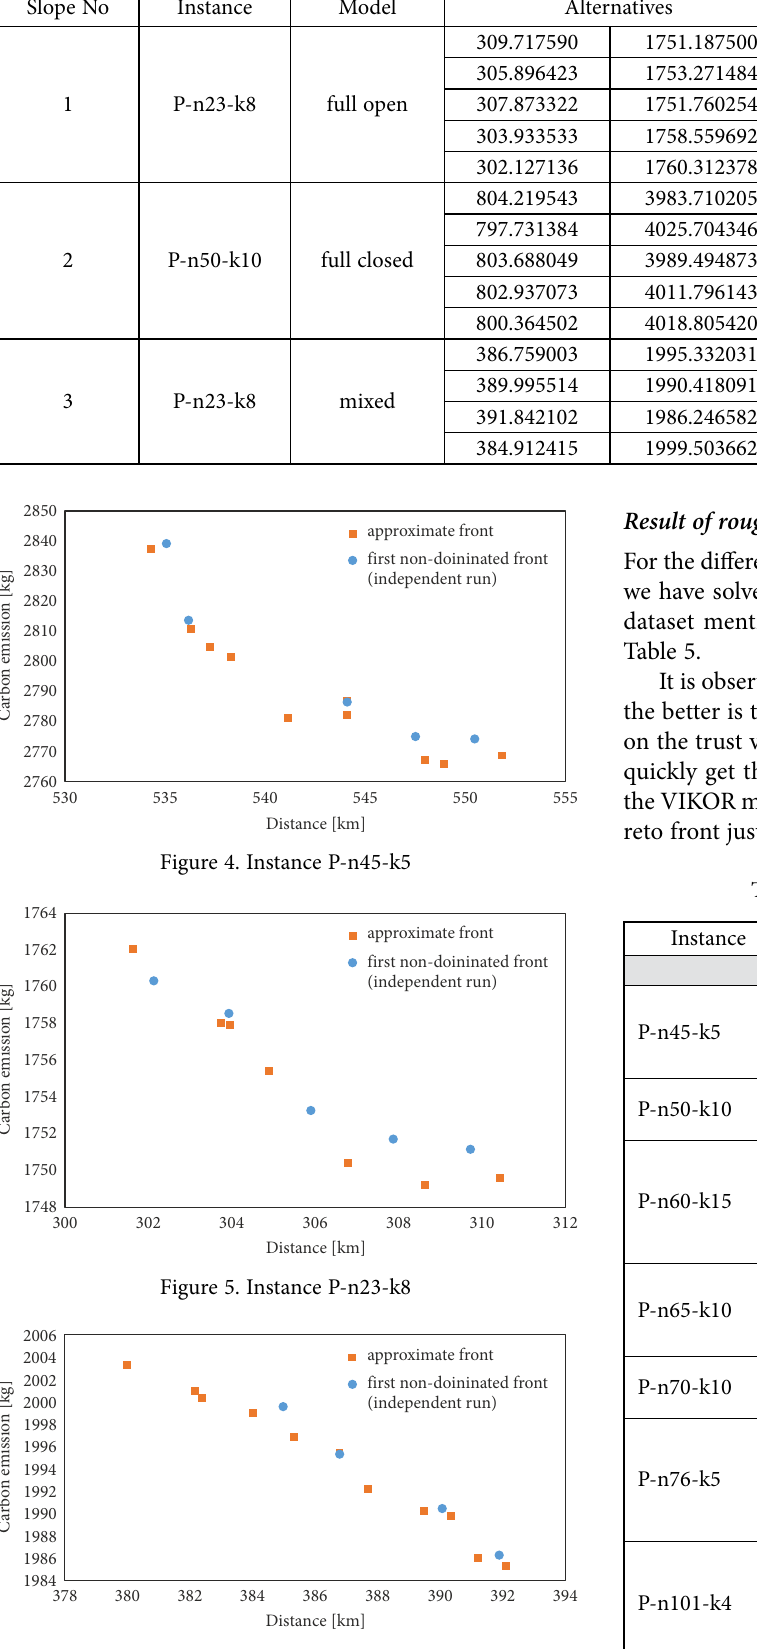
Figure 6. Instance